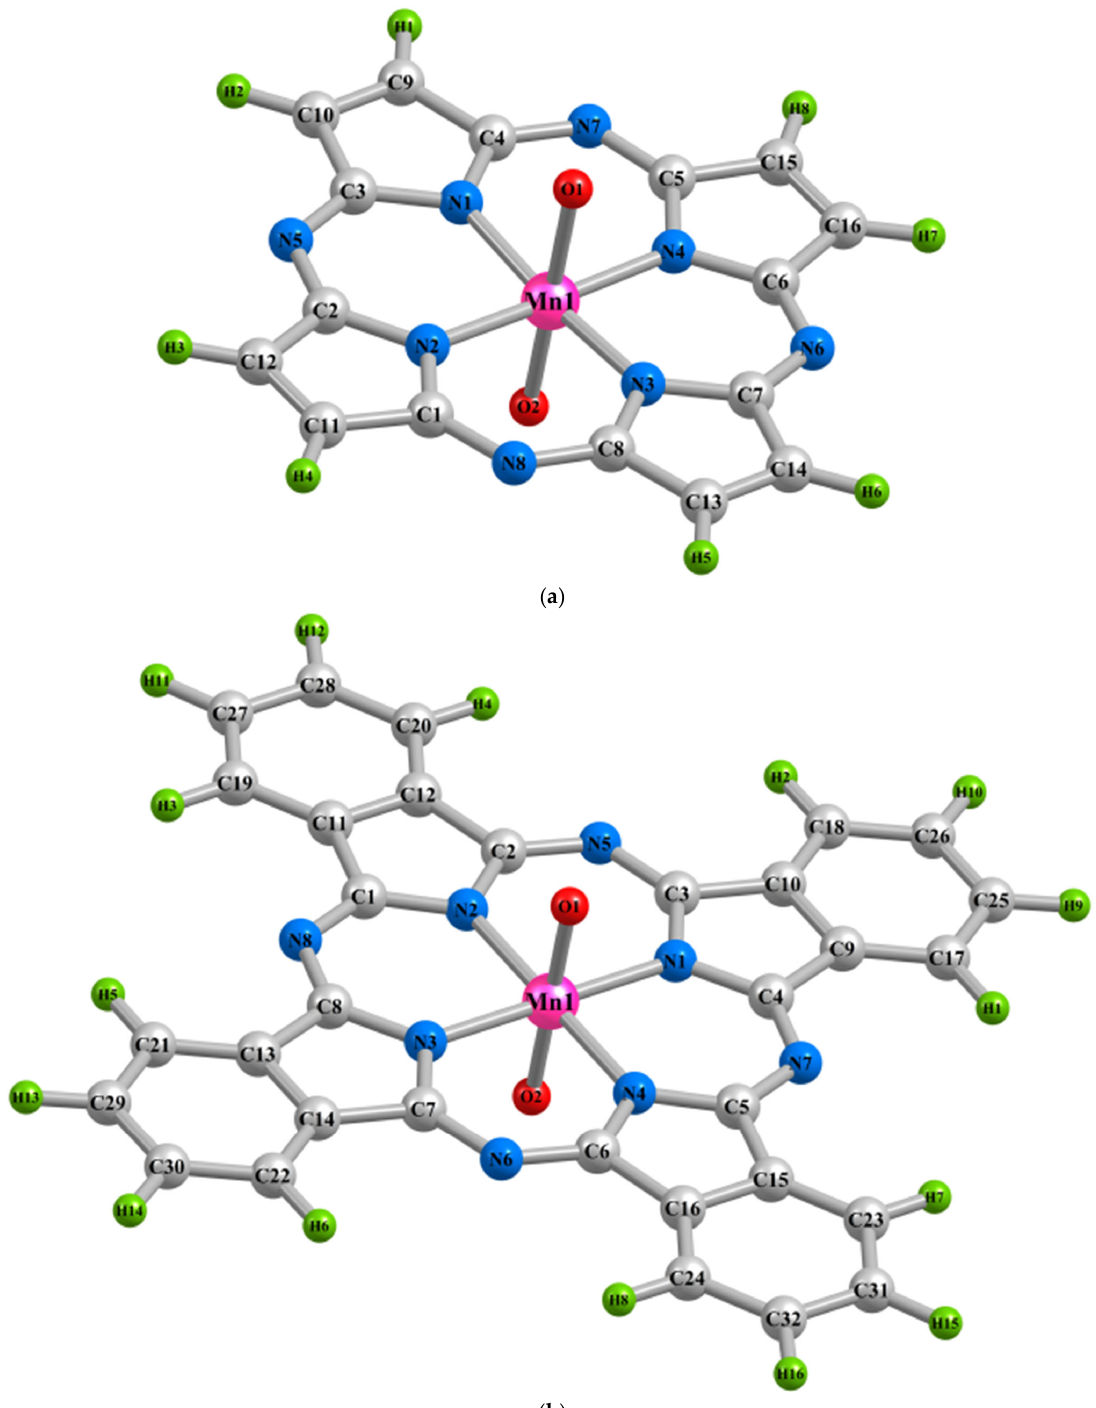
Figure 1. The pictures ofthe molecular structures of the [Mn( P )(O) 2 ] ( a ) and [Mn( Pc )(O) 2 ] ( b ) macro- cyclic complexes obtained using the DFT B3PW91/TZVP method. When forming an angle (O1Mn1O2) of 180.0 ◦ between them, according to the DFT OPBE/TZVP method, the specified value of the angle (O1Mn1O2) takes place only in the case of [Mn( Pc )(O) 2 ], while for [Mn( P )(O) 2 ] it is more than 10 ◦ less (Table 1). As for the bond angles (OMnN) formed by the “axial” oxygen atoms, the Mn atom and the nitrogen atoms entering the MnN4 chelate node, in the case of [Mn( Pc )(O) 2 ], they are equal to each other, and each of them is equal to 90 ◦ , while in the case of [Mn( P )(O) 2 ], they are